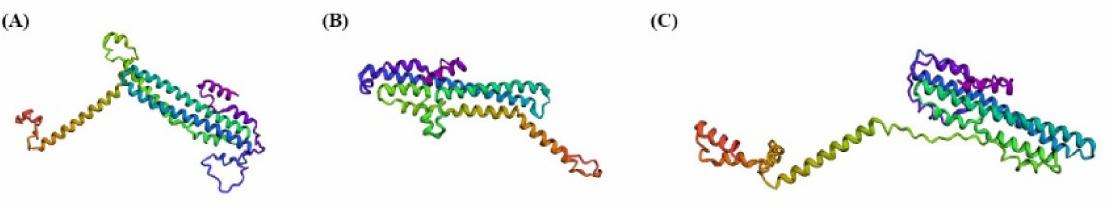
Figure 7. ( A – C ) The predicted 3D structure of three SpSPX proteins by trRobetta server, ( A )-SpSPX1 protein, ( B )-SpSPX2 protein, and ( C )-SpSPX3